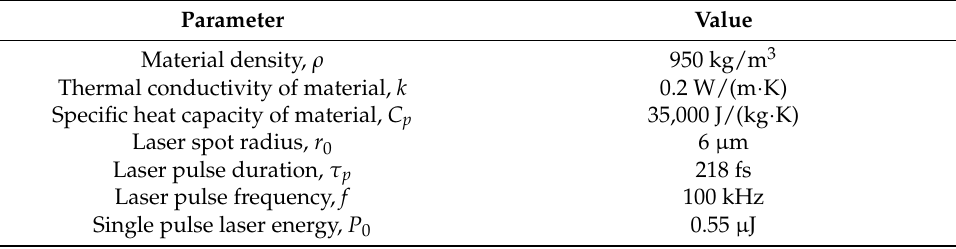
Table 1. The values of simulation parameters for laser ablation threshold.